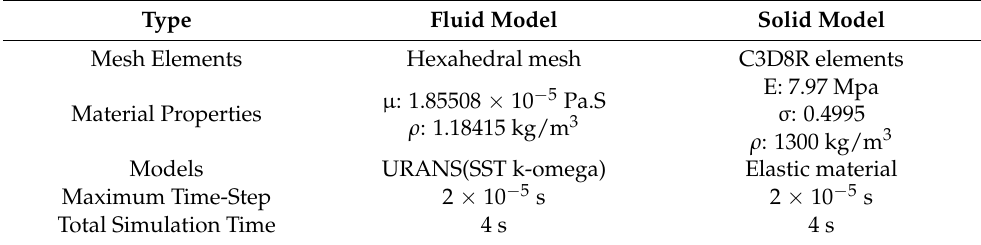
Table 1. The relevant parameters for the FSI